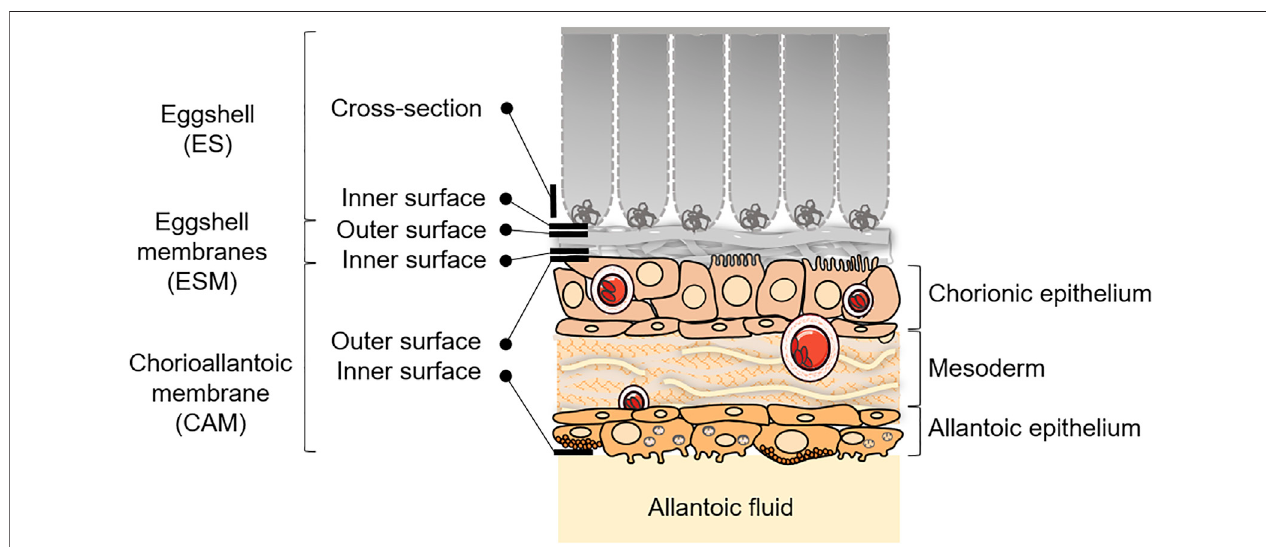
FIGURE 1 | Schematic representation of the ES and CAM, with sampling/visualization strategies depicted for the microscopy analyses at EID11 and EID15. AdaptedfromHinckeetal.,2019andHalgrainetal.,2022.SomeelementswereobtainedfromServierMedicalArt(https://smart.servier.com),licensedunderaCreative Commons Attribution 3.0 Unported